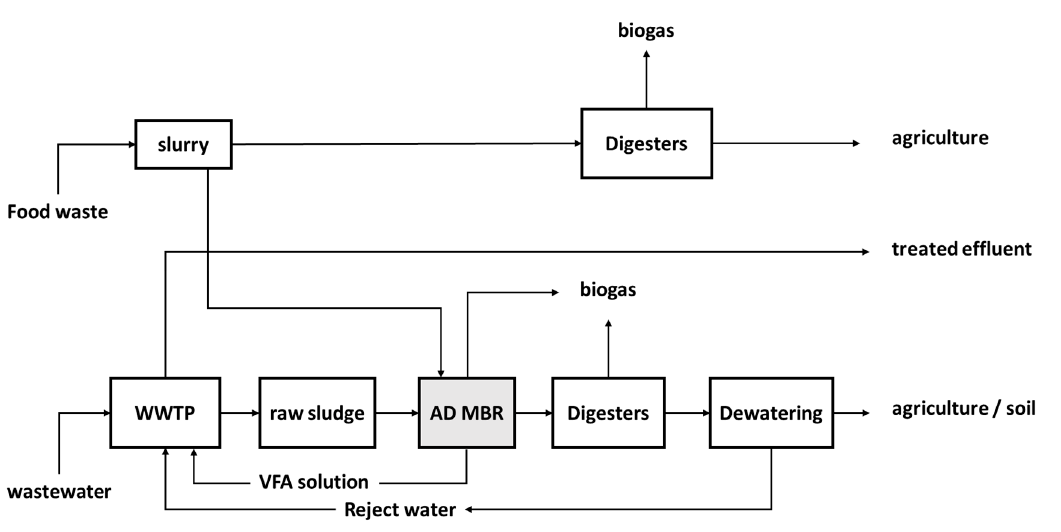
Figure 13. An overview of the proposed scenario with an MBR system treating sludge and food waste at Gryaab AB.